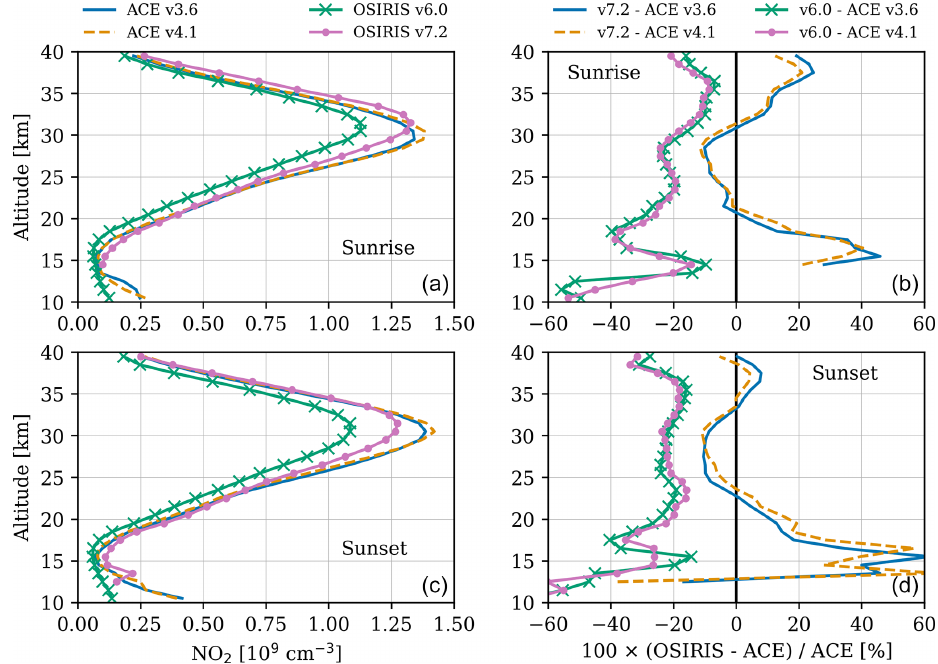
Figure 8. Comparison of mean coincident ACE-FTS and OSIRIS NO 2 profiles from 5 to 15 ◦ latitude. (a, b) ACE-FTS sunrise occultations. (c, d) ACE-FTS sunset